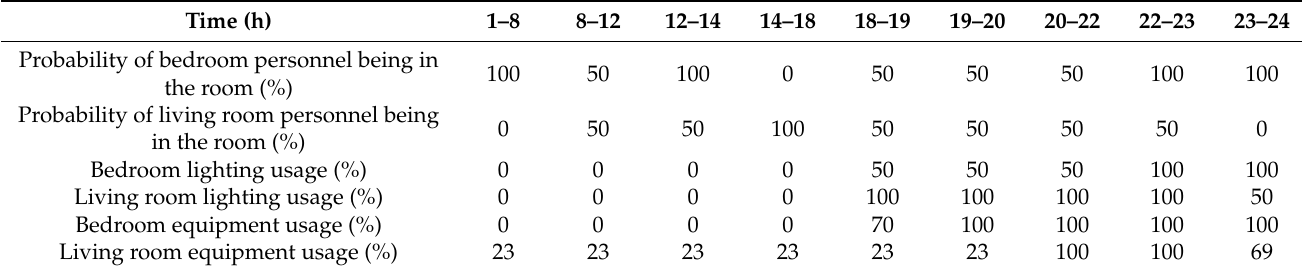
Table 5. Setting of design parameters for office building (type 3).